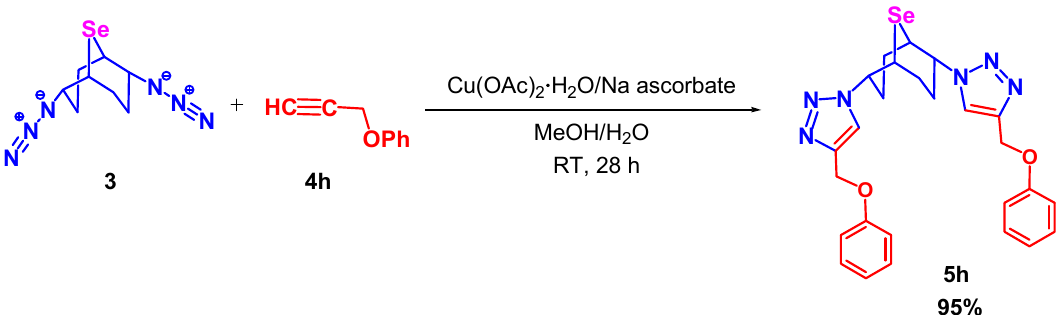
Scheme 5. Synthesis of compound 5h by the 1,3-dipolar cycloaddition reaction of diazido derivative 3 with phenylpropargyl ether 4h .